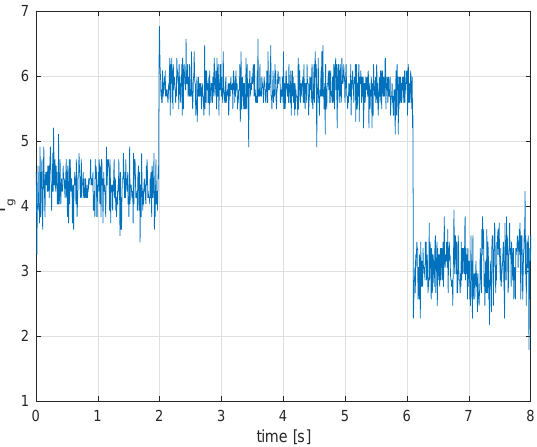
Figure 20. Experimental Result: Generator current.